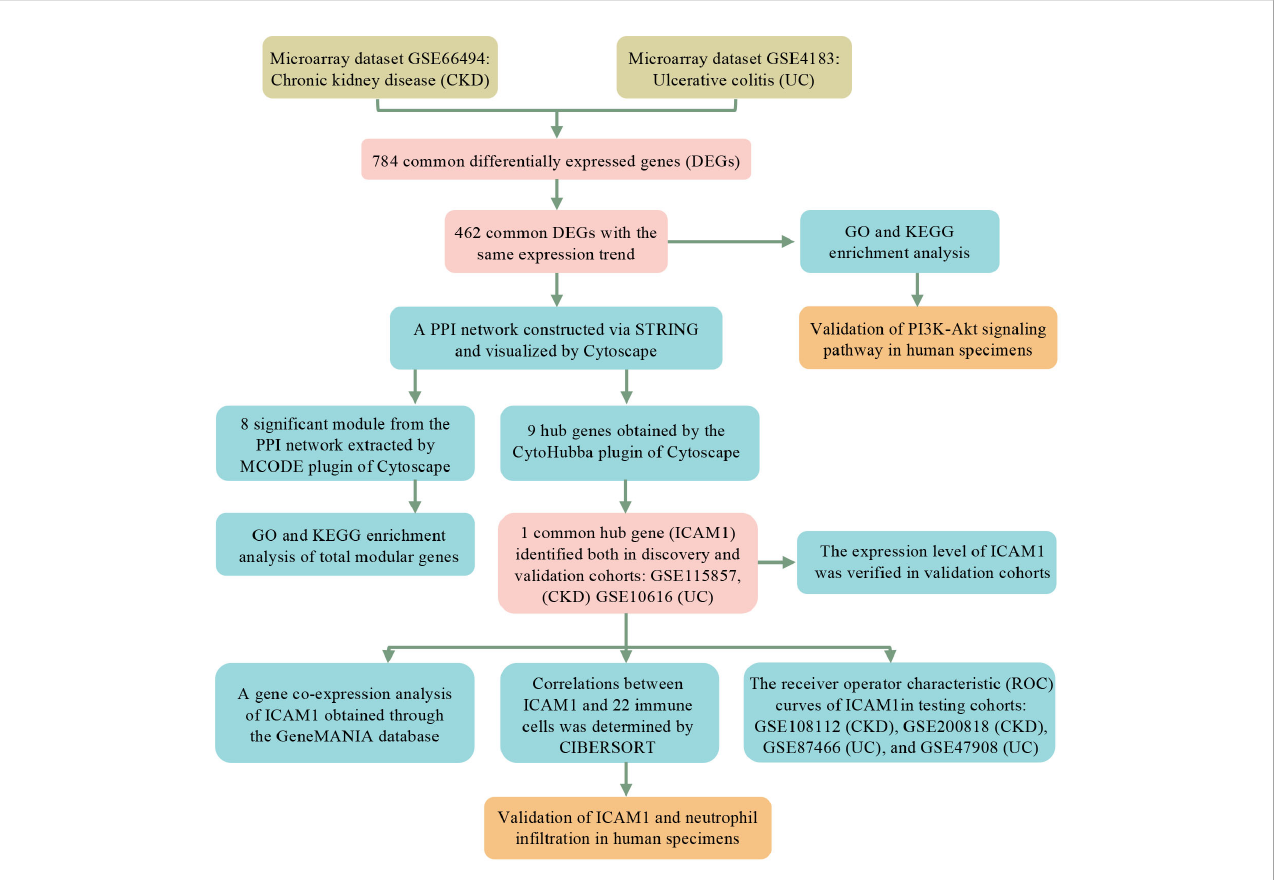
FIGURE 1 Research design fl ow